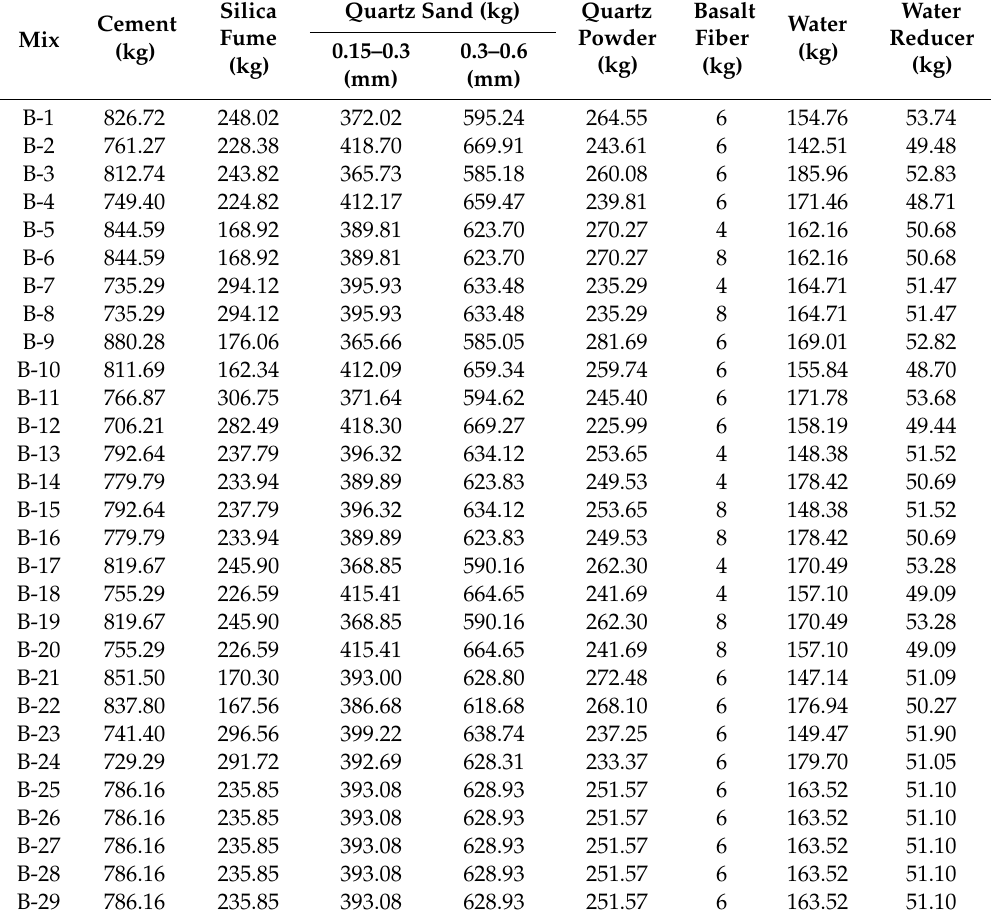
Table 4. The mix proportions of basalt fiber reactive powder concrete